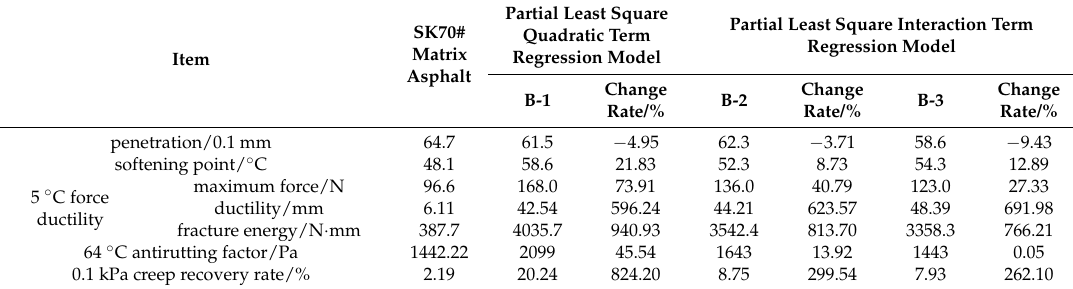
Table 9. Performance test results of optimal